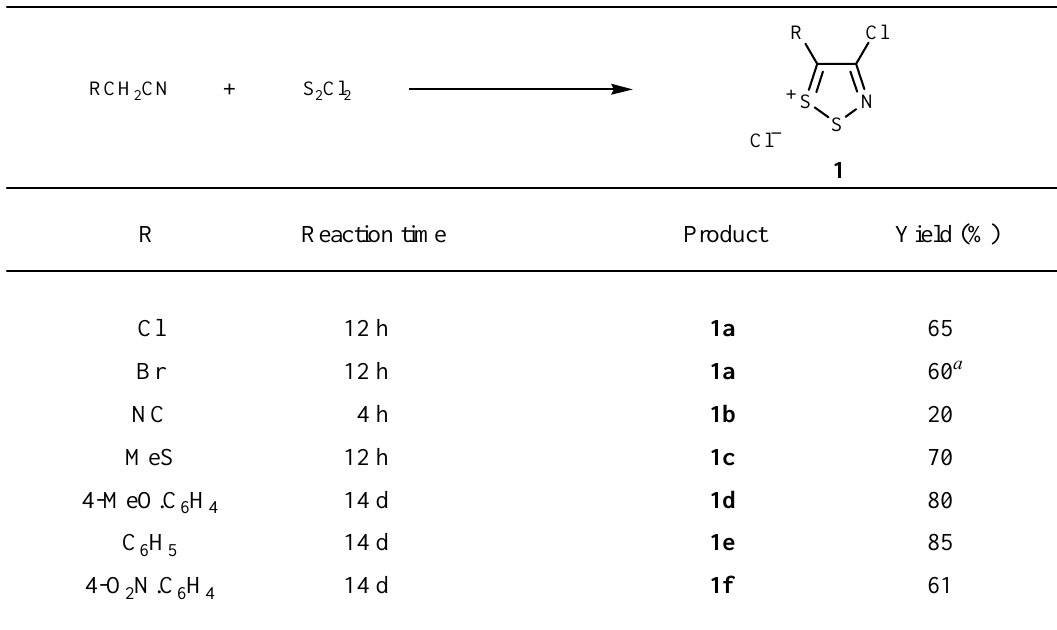
Cl in CH Cl at room temperature to 2 2 2 2